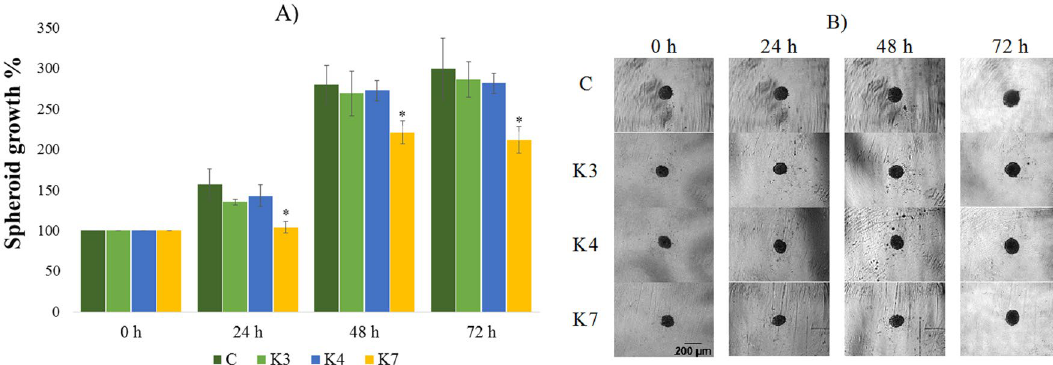
Figure 6. The impact of K3 , K4 , K7 compounds (1 µM) on resistant MCF-7/PAX spheroids formation after 24, 48, and 72 h exposure ( A ). Representative images of resistant MCF-7/PAX spheroids at 0–72 h of experiment ( B ), scale bar = 200 µm. The control spheroids ( C ) were treated with 1% V/V DMSO. After incubation, the spheroid areas were determined and the spheroid growth was calculated ( A , relative to control). Data are expressed as the average of spheroid growth (%) of nine repetitions with the corresponding standard error of the mean. The statistical differences between the control spheroids and treated spheroids were calculated by using a two-compound t-test at the level *p < 0.05, **p < 0.01, ***p < 0.001.